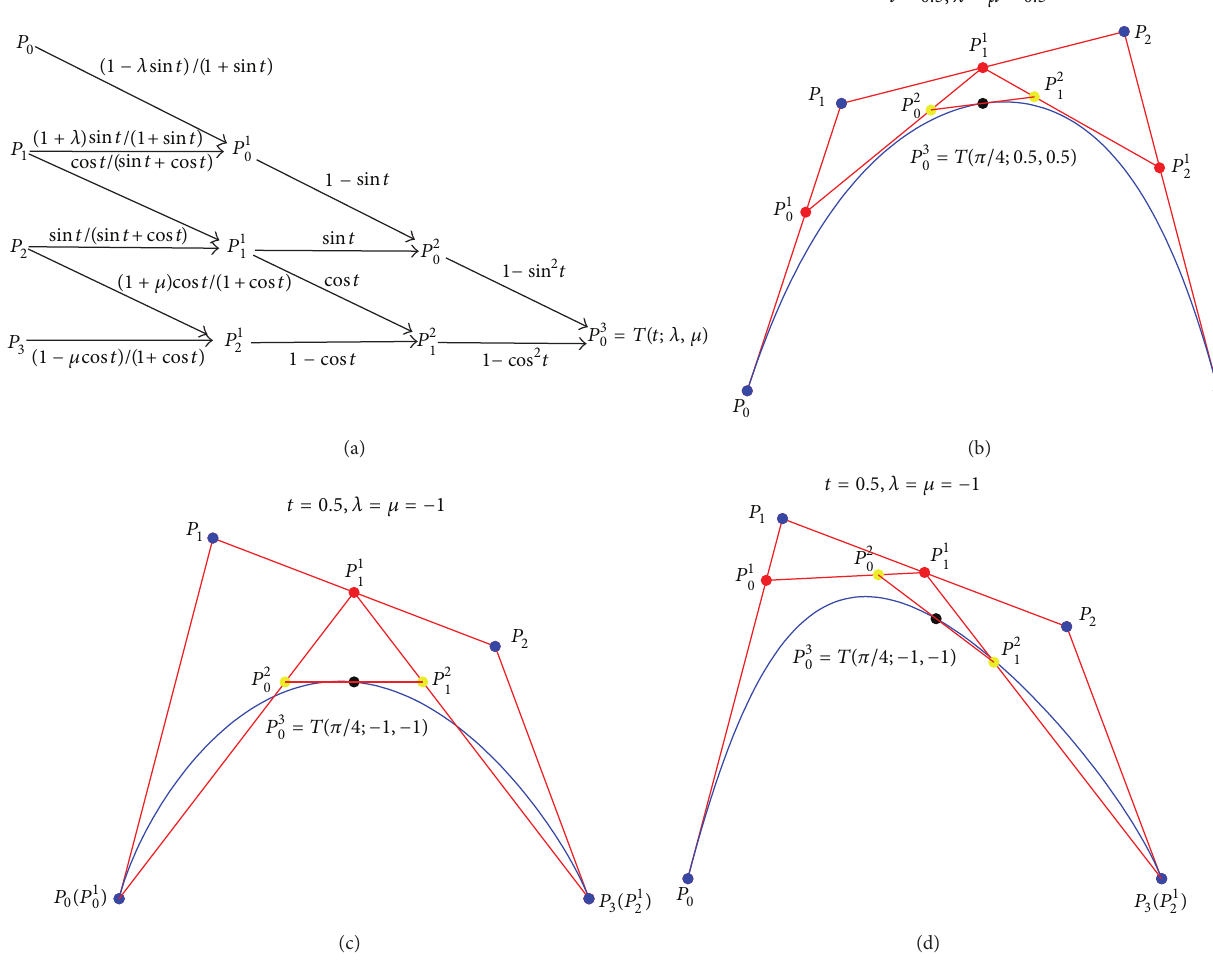
Figure 1: Corner cutting